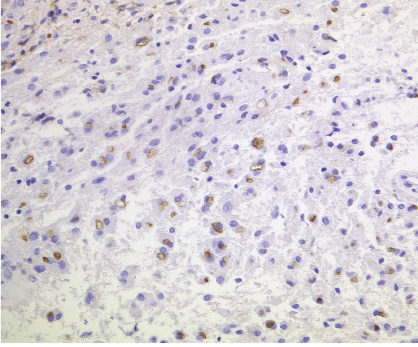
Figure 4: Paranuclear and ring-like structures were seen in the anti- EMA reaction (anti-EMA, ABC, × 200, original magnification).